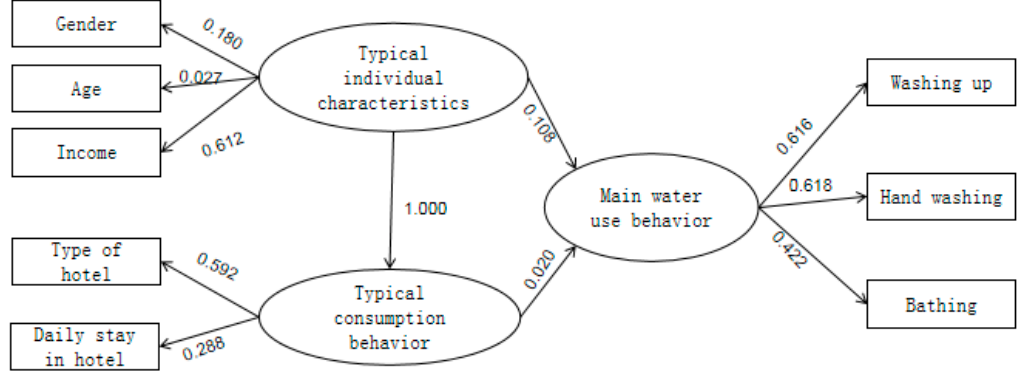
Figure 6. Parameter diagram of typical water-use behavior model of hotel consumers. Table 5. Regression coe ffi cient of typical water-use behavior model of hotel consumers.